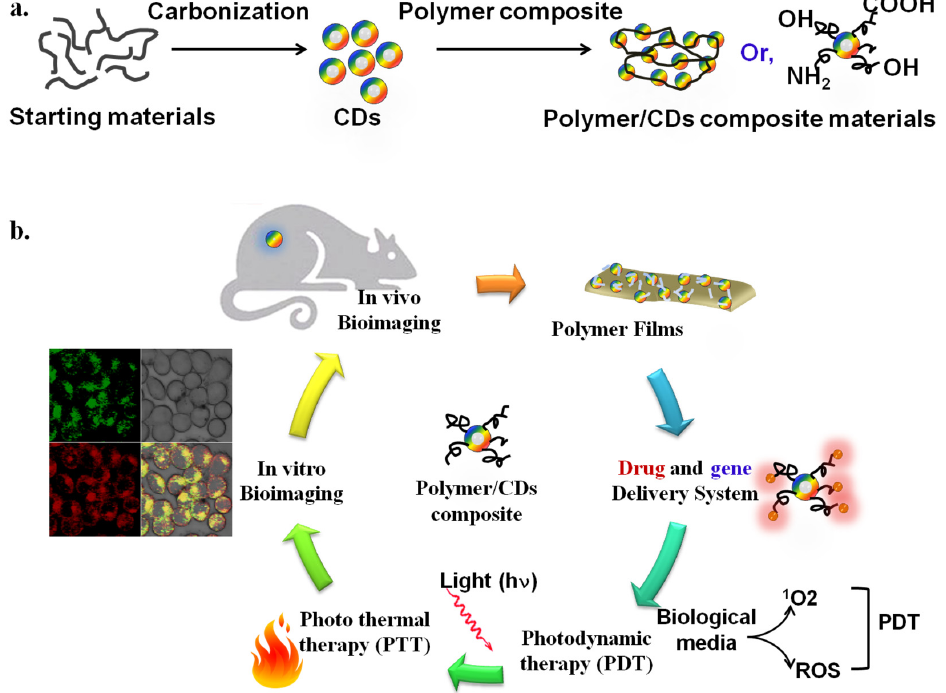
Figure 1. ( a ) Schematic diagram of the synthesis of CDs from starting materials (first) and